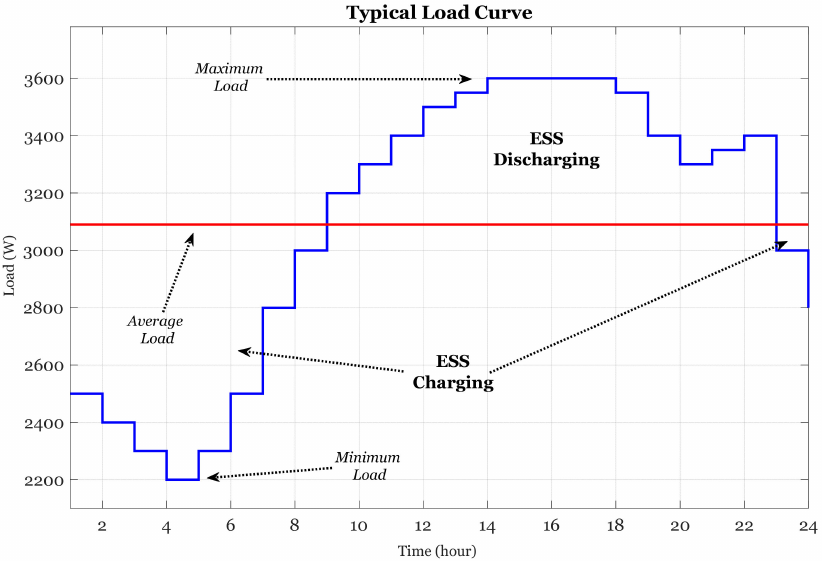
Figure 2. Decomposing of typical load